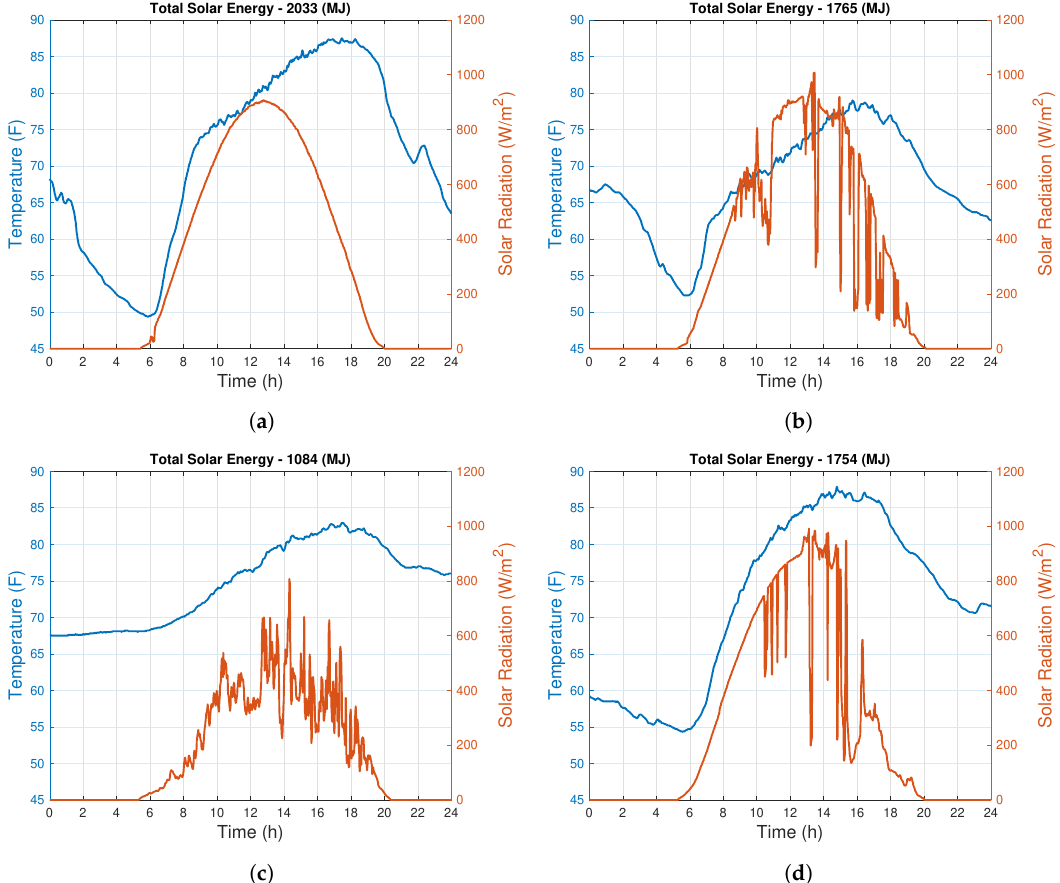
Figure 5. Solar radiation and temperature profiles for the four sky conditions. ( a ) Clear sky solar radiation and temperature profiles; ( b ) Partly cloudy sky solar radiation and temperature profiles; ( c ) Overcast sky solar radiation and temperature profiles; ( d ) Monsoon sky solar radiation and temperature